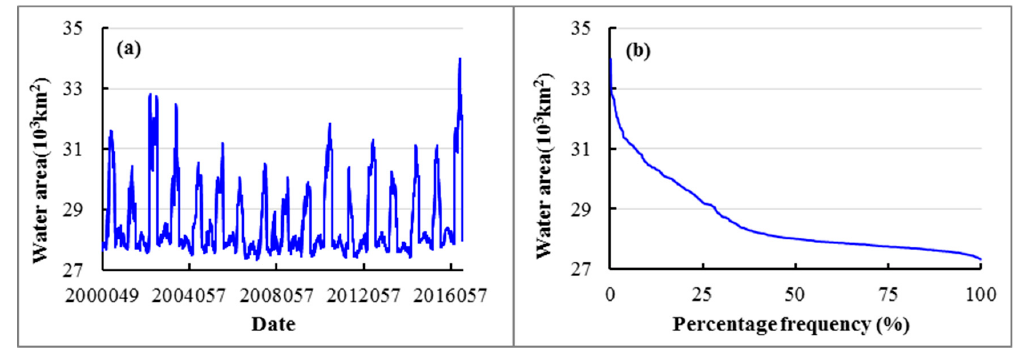
Figure 11. Surface water area of the YRB for 2001–2016. ( a ) Every 8 days series; ( b ) sorting by size. The peak, Median, and valley values of the water area for each year are counted (Figure 12). The most water year is 2016, which the peak, median and valley values of the water area are all the largest in 17 years, 33.99 × 10 3 , 30.88 × 10 3 and 27.84 × 10 3 km 2 , respectively. Other years with a large amount of water are 2002, 2003 and 2015. The year of less water includes 2001, 2006, 2007, 2008, 2009 and 2011. The minimum peak, median and valley values occurred in 2009 with water area of 29.91 × 10 3 km 2 , 2011 with water area of 28.04 × 10 3 km 2 , 2007 with water area of 27.34 × 10 3 km 2 , respectively. In addition, the years (2007 and 2011) show several abnormal values and are relatively dry, which indicators the surface water area in most of these years is small.